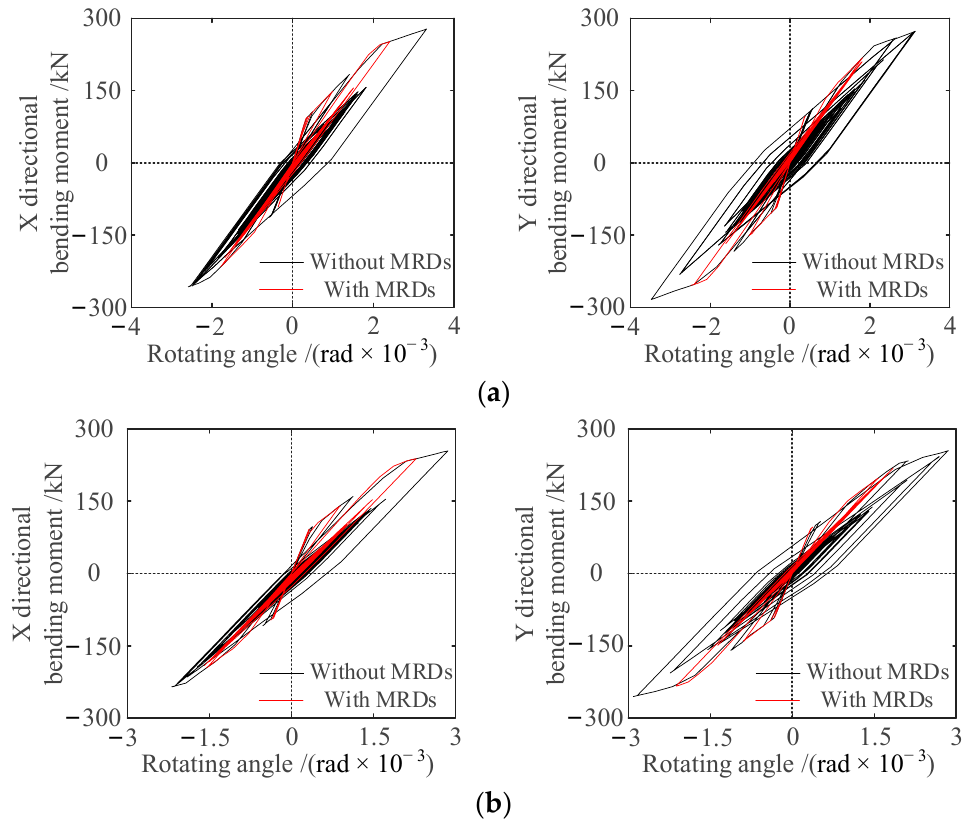
Figure 12. Bending moment-angle hysteresis loops of RC frame structures with and without MRD under El-Centro waves. ( a ) The column in third story; ( b ) the column in fourth story.